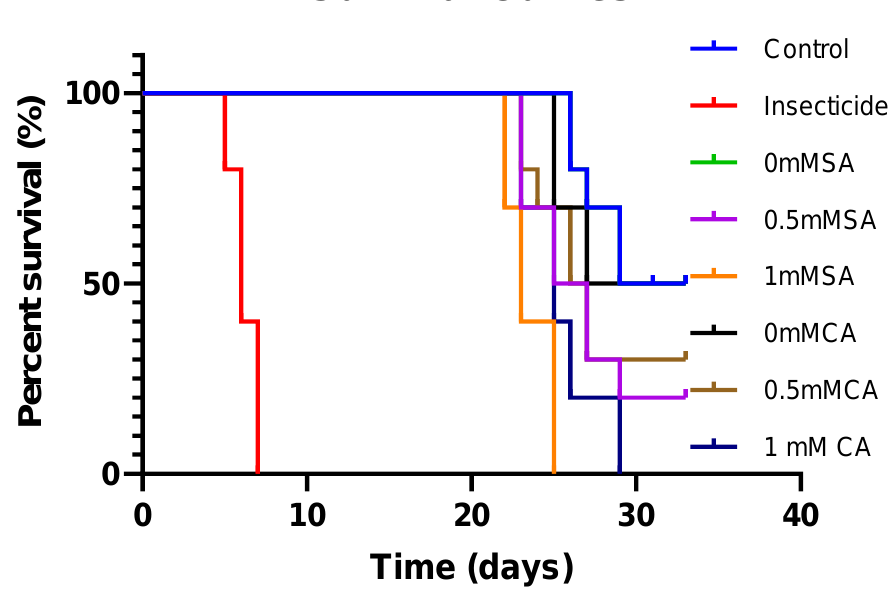
Figure 1. Kaplan–Meier survival functions of Brevicoryne brassicae under induced resistance treatments of SA (Salicylic Acid) and CA (Citric Acid) (Mantel–Cox test, p <